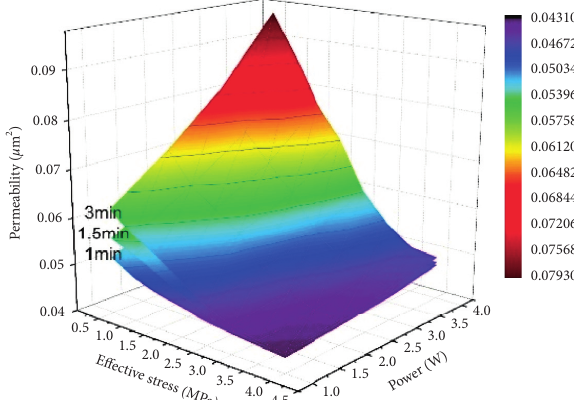
Figure 15: Three-dimensional changes of permeability under axial and confining pressures of 5